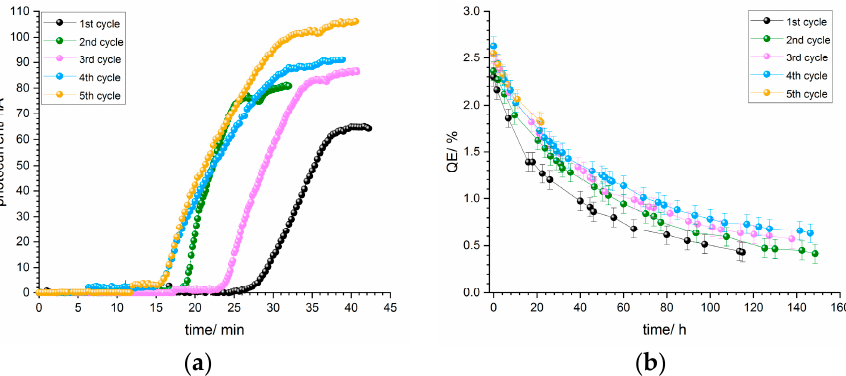
Figure 12. ( a ) Photocurrent curves of the five activations for p-GaN:Cs on silicon photocathode B2 and ( b ) QE decay curves for each activation cycle of the same sample.